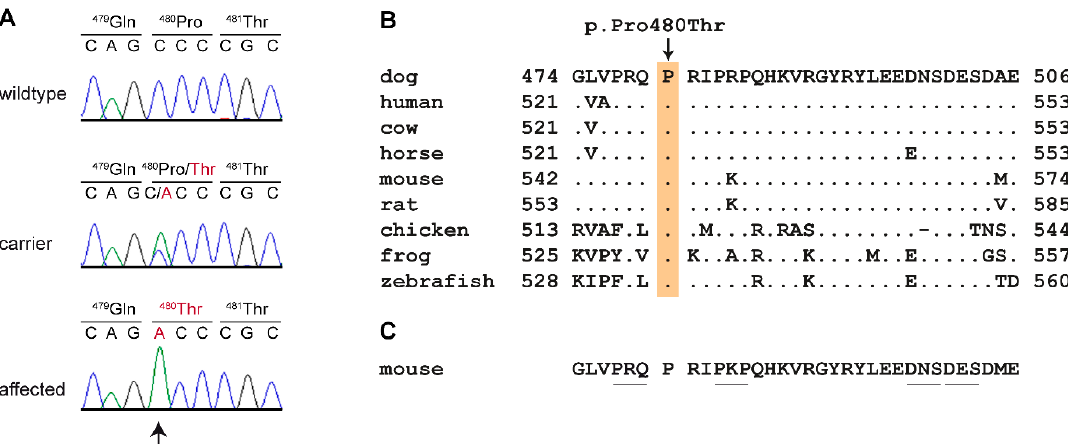
Figure 3. Details of the UNC93B1 missense variant. ( A ) Representative Sanger electropherograms from dogs with the three different genotypes at c.1438C>A are shown. The amino acid translation is indicated. ( B ) Evolutionary conservation of the SDCBP binding domain [30]. The proline at position 480 of the canine UNC93B1 protein is strictly conserved across all vertebrates. The sequences